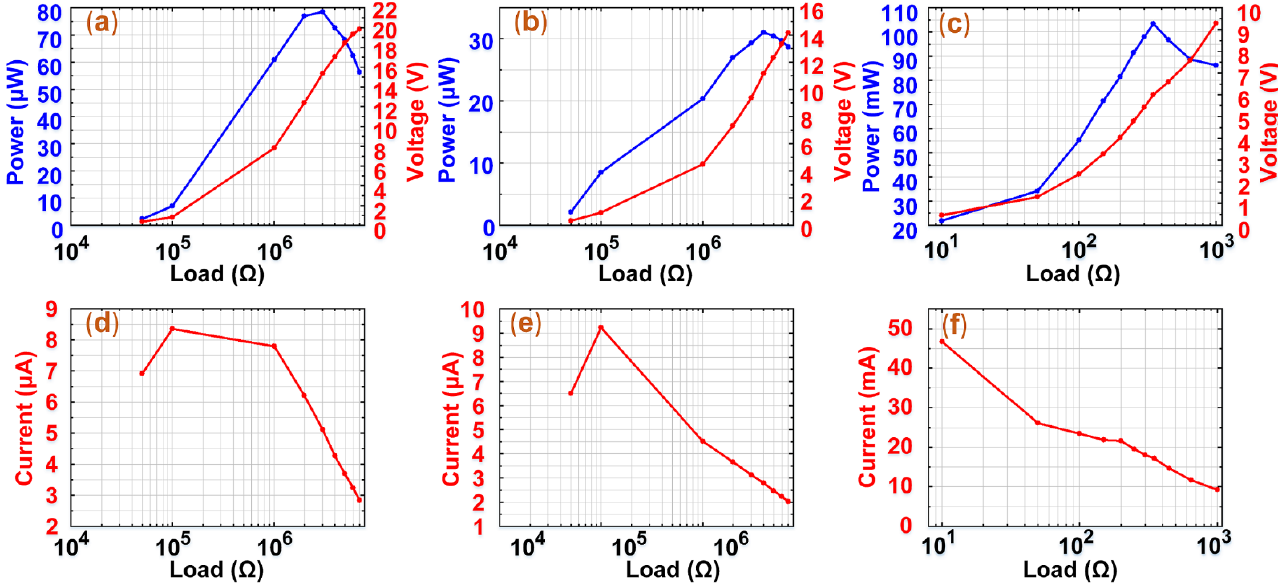
Figure 7. The output power, voltages, and currents of the BC-PEH and hybrid harvester. ( a – c ) The peak-to-peak output power and voltages of the BC-PEH, PEH, and EMEH. ( d – f ) The peak-to-peak output currents of the BC-PEH, PEH, and EMEH.